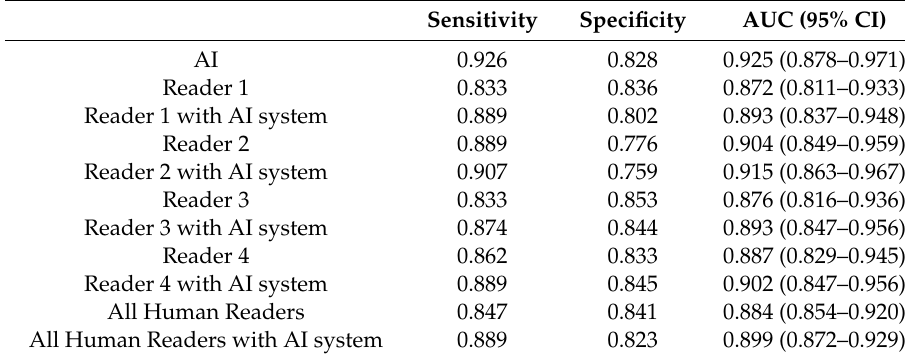
Table 3. Diagnostic performance of human readers and the AI